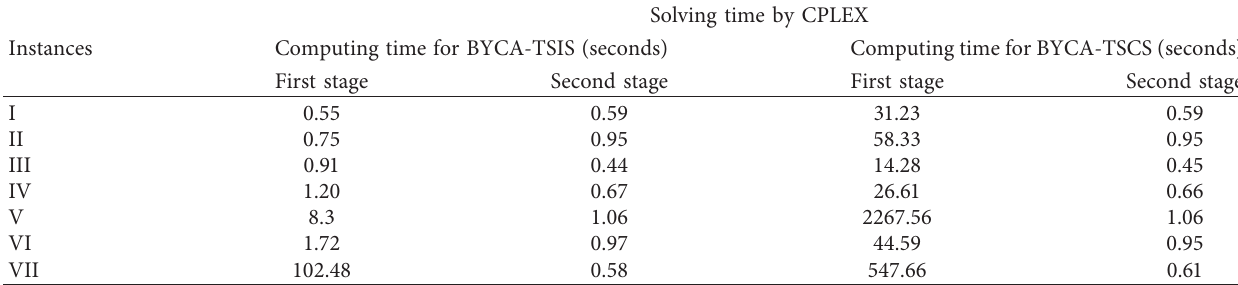
Table 12: Solving time by CPLEX for BYCA-TSIS and